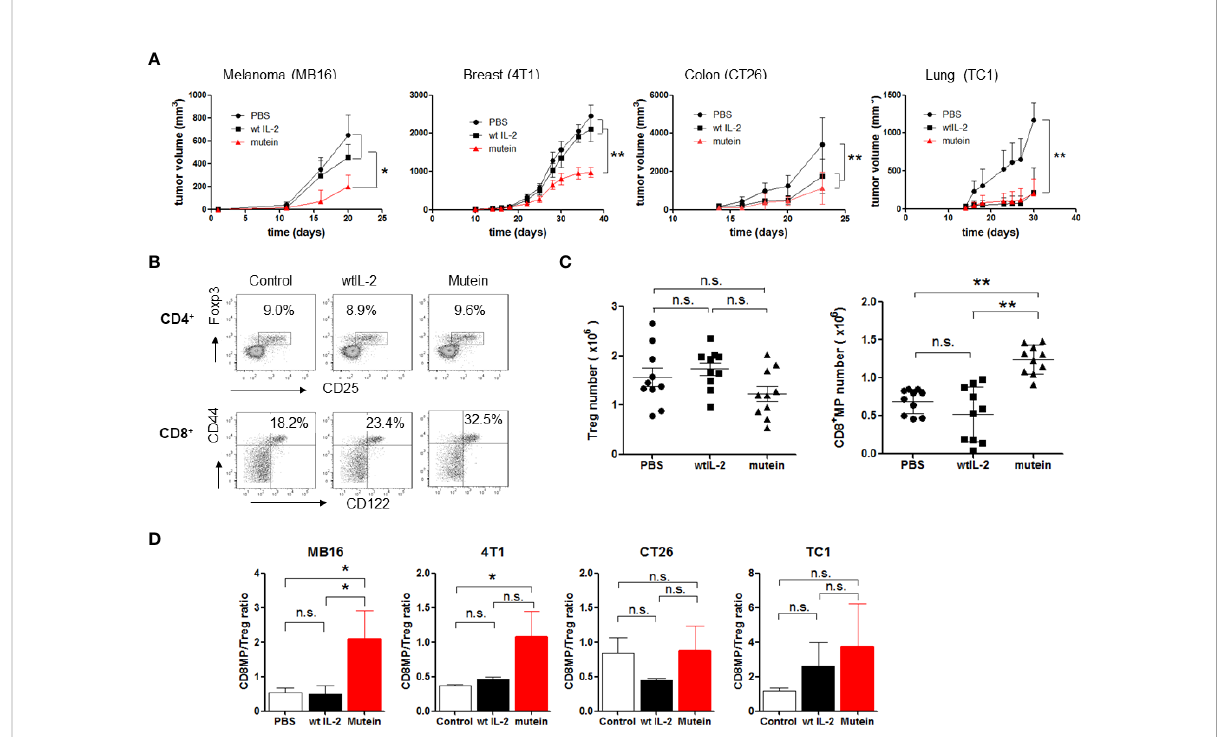
FIGURE 2 No-alpha mutein induces a potent antitumor effect in four different tumor models and is able to change CD8 + MP/Treg balance in tumor- bearing mice in the spleens. Mice were inoculated with tumor cells and received 300 IU of mutein or 30,000 IU wtIL-2, twice a day, for 2 weeks separated by a resting week. MB16, CT26, and TC-1 cells were inoculated s.c. on the right fl ank; 4T1 cells were inoculated on mammary glands. (A) Tumor growth curves. (B) Representative dot plots from spleen of MB16-bearing mice. (C) CD8 + MP and Treg number from spleens of MB16-bearing mice. (D) CD8 + MP/Treg ratios on spleens of mice inoculated with the different tumor cell lines. Cumulative data from three experiments, n = 9 per treatment. Statistical differences in tumor growth were determined by two-way ANOVA test, using GraphPad software (p < 0.001 **; p < 0.05 *). n.s., non signi fi